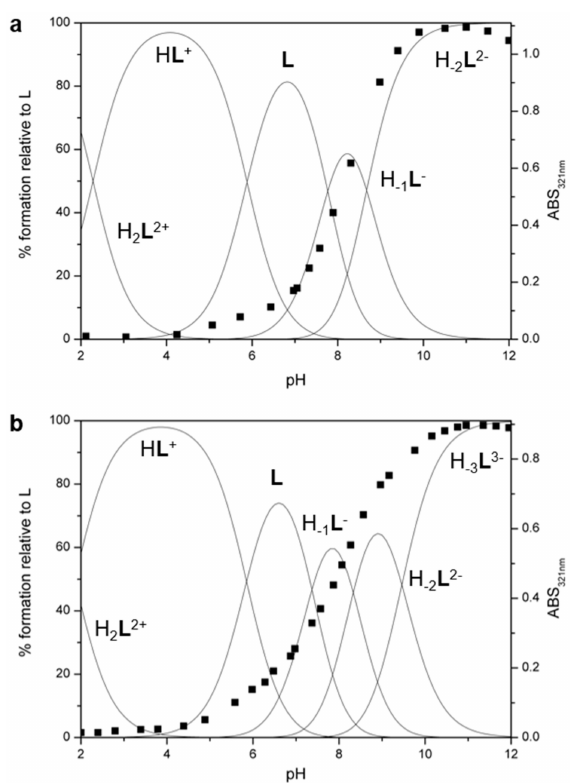
Figure 2. Distribution diagram of the species ( − ) and trend of the absorbance ( (cid:4) ) for ( a ) L1 and ( b ) L2 ( λ = 321 nm) in aqueous solution as a function of pH. UV-Vis measurements: [ L1 ] = [ L2 ] = 4.4 × 10 − 5 mol dm − 3 ; potentiometric measurements: [ L1 ] = [ L2 ] = 1 × 10 − 3 mol dm − 3 , I = 0.15 mol dm − 3 NaCl and NMe 4 Cl for L1 and L2 , respectively, T = 298.1 K.